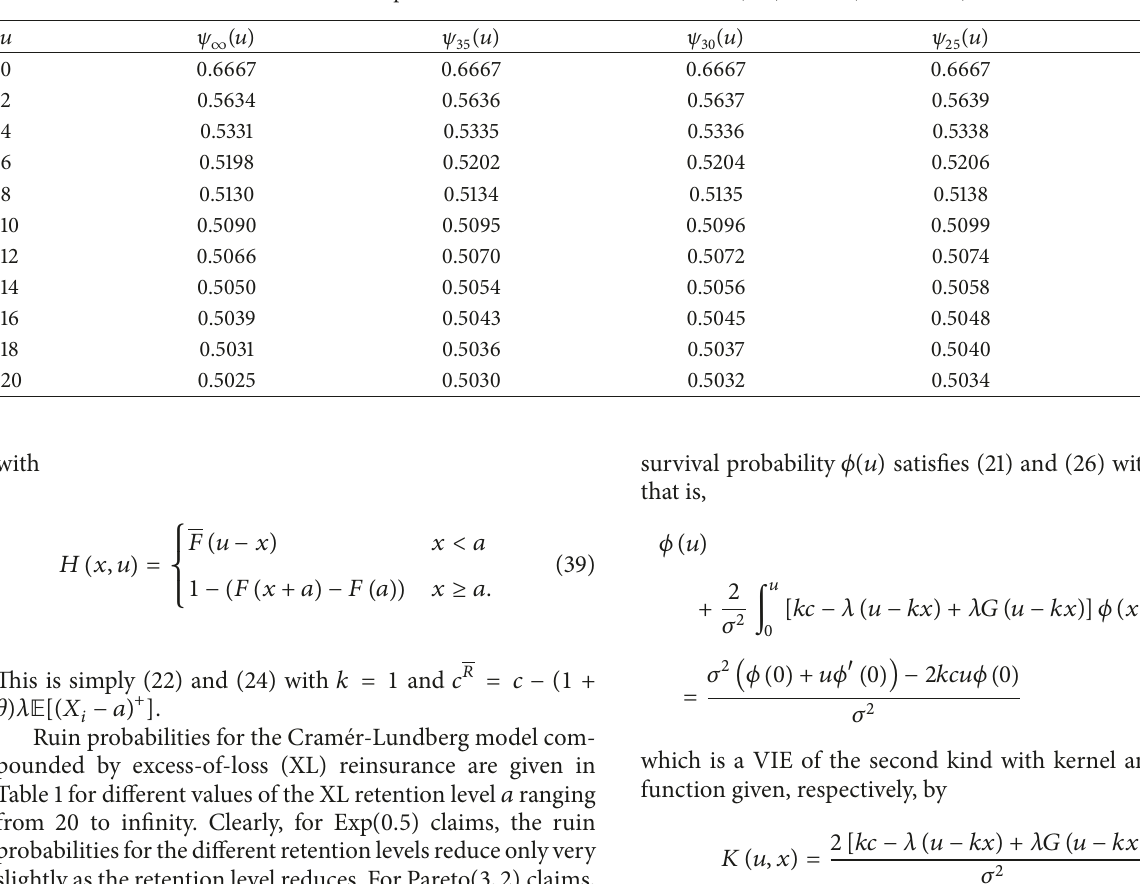
Table 2: Ruin probabilities for XL reins. in CLM: Par (3,2) claims ( 𝜆 = 2, 𝑐 = 6